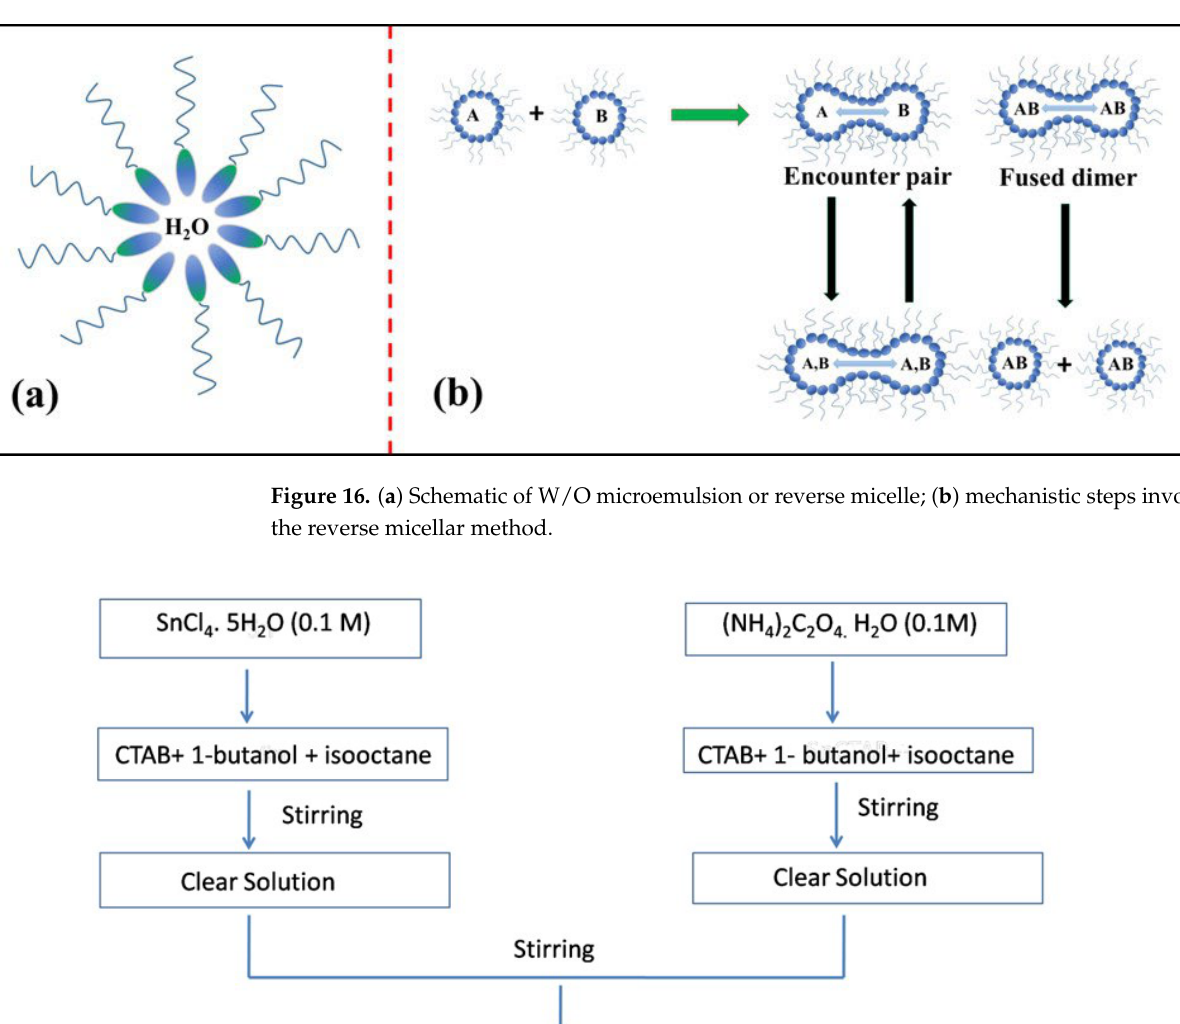
Figure 16. ( a ) Schematic of W/O microemulsion or reverse micelle; ( b ) mechanistic steps involved in the reverse micellar method.